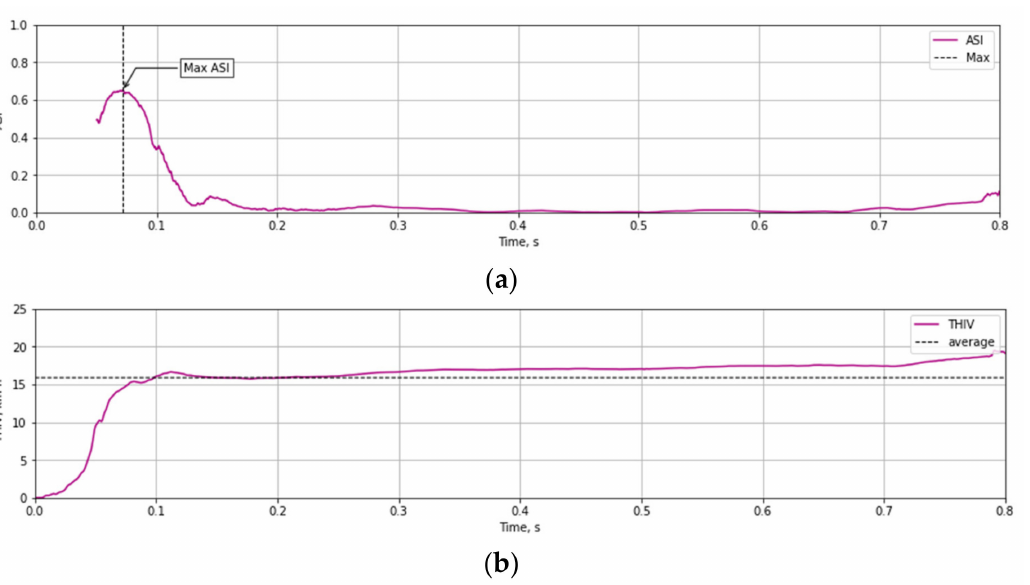
Figure 14. Experimental courses of the values of injury intensity parameters ( a ) ASI, ( b ) THIV as a result of an impact against T03 mast at 35 km/h.